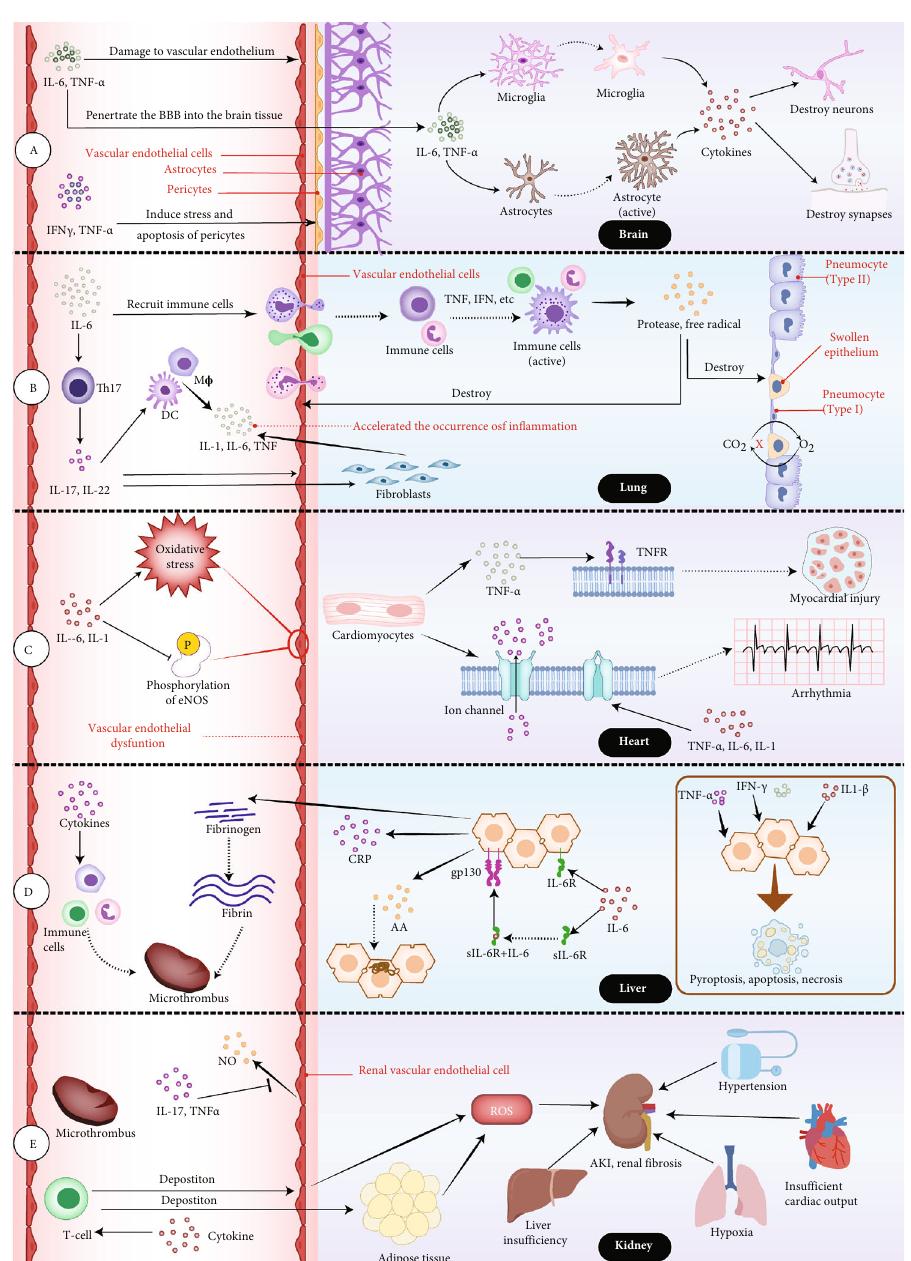
Figure 3: The mechanism of organ damage in cytokine release syndrome. (a) The mechanism of brain damage in cytokine release syndrome. IL-6 and TNF- α act on the vascular endothelium to increase the permeability of the BBB and activate the astrocytes and microglia to release cytokines, impacting the structure and function of neurons and synapses. (b) The mechanism of lung injury in cytokine release syndrome. Immune cells are recruited to the lungs by IL-6 and activated by cytokines such as TNF and IFN, generating huge amounts of free radicals and proteases, causing pulmonary edema and gas exchange problems. (c) The mechanism of heart damage in cytokine release syndrome. TNF- α and IL-6 can increase oxidative stress, reduce eNOS phosphorylation, and cause coronary endothelial dysfunction. Excessive TNF- α binding to receptors on cardiomyocytes can cause myocardial damage and dysfunction. TNF- α , IL-6, and IL-1 regulate the expression and function of ion channels on myocardial cell membranes, leading to arrhythmia. (d) The mechanism of liver injury in cytokine release syndrome. IL-6 binds IL-6R across the membrane to exert an anti-in fl ammatory e ff ect. When IL-6 levels rise, it can combine with sIL-6R to promote in fl ammation and induce the production of acute phase proteins, culminating in microthrombosis and liver amyloidosis. (e) The mechanism of kidney injury in cytokine release syndrome. IL-17 and TNF- α work synergistically to suppress NO production in the vascular endothelium and enhance blood vessel contraction. Due to the chemotaxis of cytokines, T cells are deposited in blood vessels and enter tissues to produce ROS, leading to kidney damage and renal fi brosis. Microthrombi entering the renal capillary network can easily form microinfarction foci, leading to acute necrosis of renal tubules. Abbreviations: BBB: blood – brain barrier; eNOS: endothelial nitric oxide synthase; sIL-6R: soluble IL-6 receptors; NO: nitric